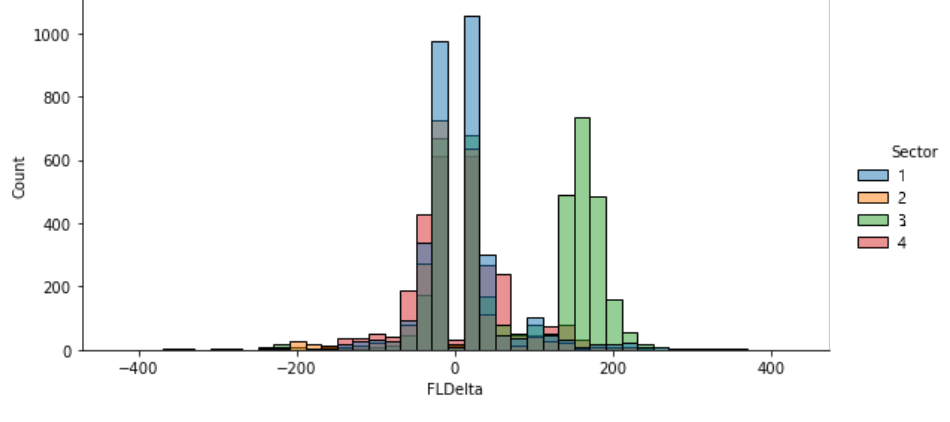
Figure 5. FLDelta of evolution flights by sector.